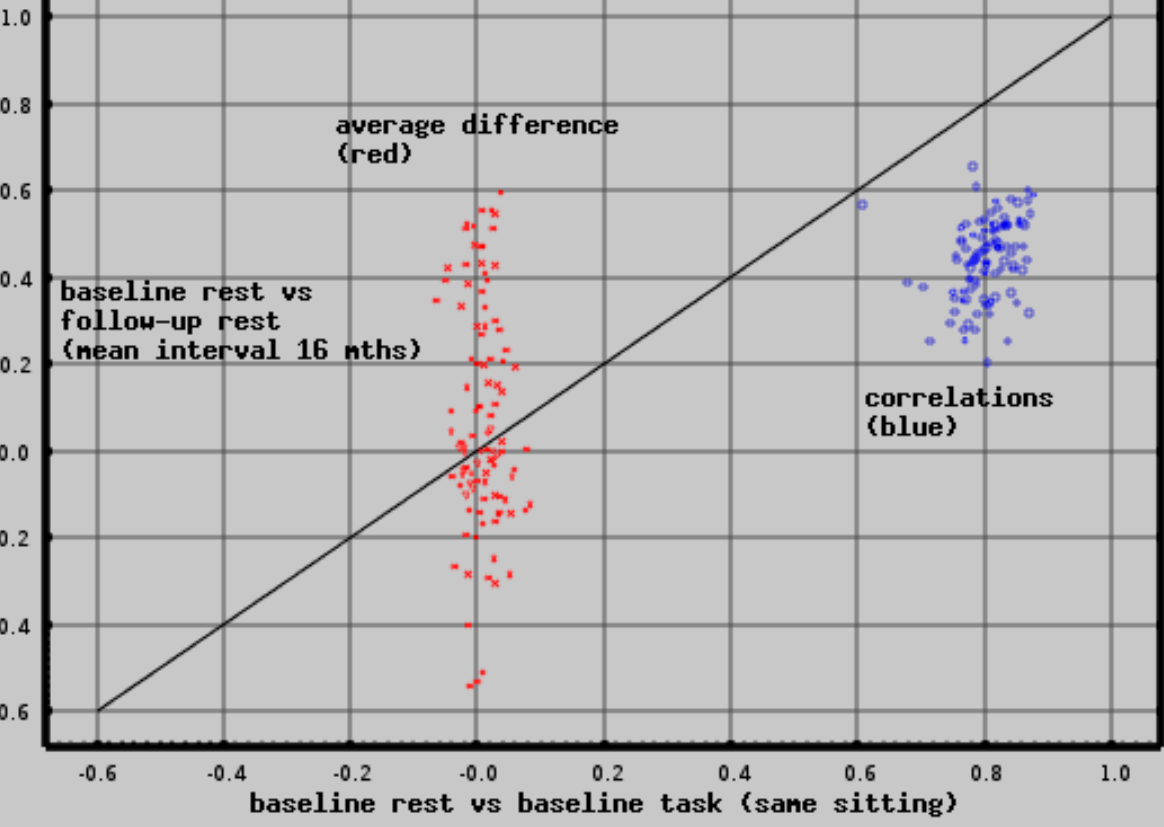
Figure 6. Short-term (same sitting) vs. long-term ( mean 16-months) test-retest reliability is plotted for each of the 103 cortical, subcortical, and deep white matter regions. Regional measures ( z-scores ) of tonic neuroelectric activity were compared across all CamCAN subjects. Comparisons were between baseline resting and task recordings (short-term reliability, about one hour) and between baseline and follow-up resting recordings (long-term reliability, mean 16-month interval). Correlations (blue) and mean differences (red) are plotted—short term (x-axis) vs. long term (y-axis). Long-term test-retest reliability shows reduced correlations and increased differences. Note that mean differences >0.1 or < − 0.1 are typically significant with p < 0.03.